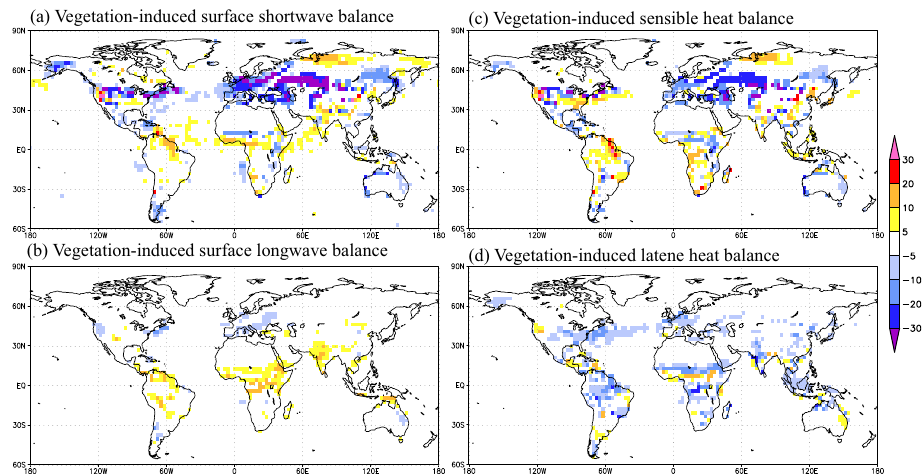
Fig. 6. (a) Annually averaged contribution of vegetation change (which was calculated as (AOV(LGM) − AOV(PI)) − (AO(LGM) − AO(PI)) Annually averaged contribution of vegetation change (which was calculated as to surface shortwave balance [Wm − 2 ] (downward positive), (b) same as (a) but surface longwave balance [Wm − 2 ] (upward positive), ( AOV(LGM) − AOV(PI) ) − ( AO(LGM) − AO(PI) ) to surface shortwave balance [W/m 2 ] (down- (c) same as (a) but surface sensible heat balance [Wm − 2 ] (upward positive) and (d) same as (a) but surface latent heat balance [Wm − 2 ] ward positive), (b) as same as (a) but surface longwave balance [W/m 2 ] (upward positive), (c) (upward positive). as same as (a) but surface sensible heat balance [W/m 2 ] (upward positive) and (d) as same as (a) but surface latent heat balance [W/m 2 ] (upward positive).